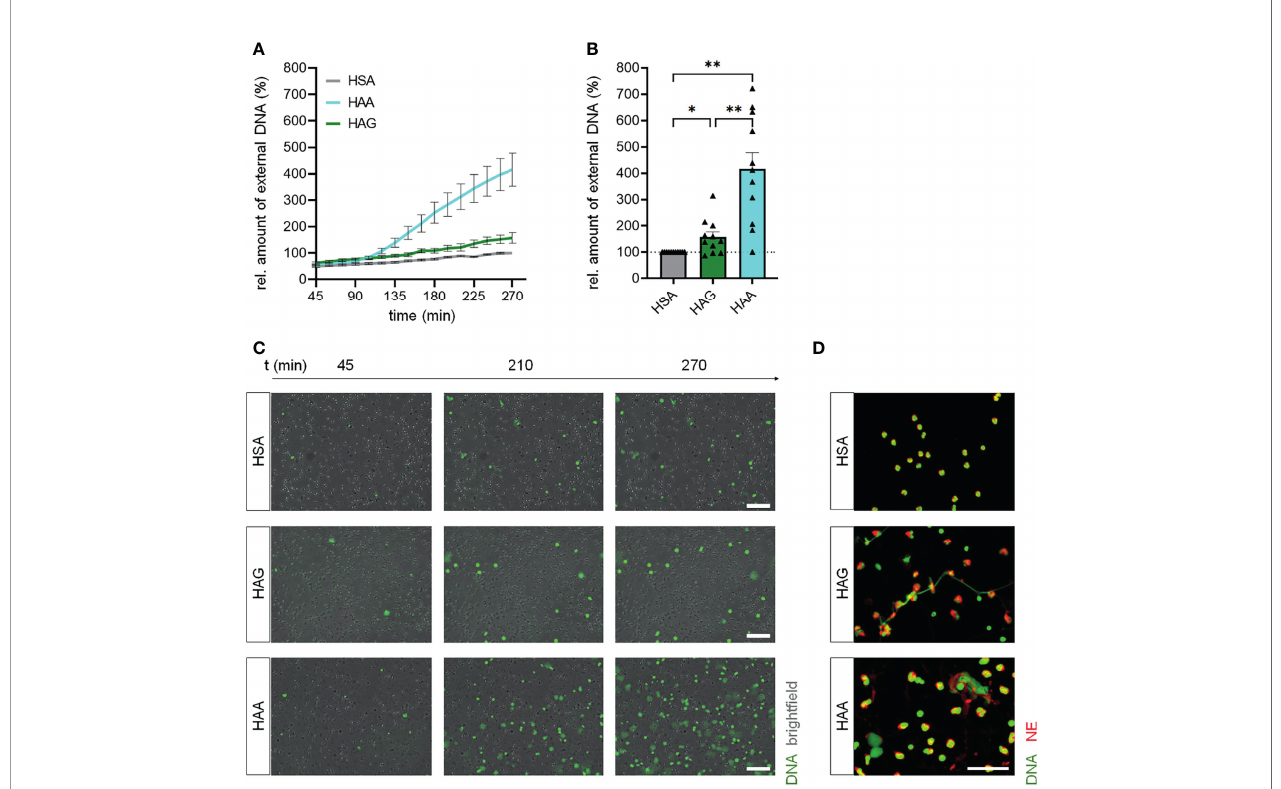
FIGURE 1 | IgA complexes show higher potential to induce NETs than IgG complexes. (A – C) Isolated human blood neutrophils were stimulated with 150 µg/ml heat-aggregated IgG (HAG), heat-aggregated IgA (HAA) or human serum albumin (HSA) as control. NET formation was measured by staining extracellular DNA with Sytox Green. (A) NET formation over time. (B) Relative amount of extracellular DNA 270 min after stimulation normalized on HSA treatment. The dashed line represents the relative amount of NETs of the HSA treated control. N = 11 donors. (C) Representative images at 3 different time points. Scale bar = 100 µm. (D) Representative images of fi xed NETs 270 min after stimulation with HSA, HAG or HAA. Neutrophil elastase (NE) is shown in red, DNA is shown in green. Scale bar = 50 µm. Data are presented as mean ± SEM (A) or scatter plots with bars showing mean and SEM (B) . Signi fi cance was tested with repeated measures one way ANOVA with Geisser Greenhouse correction and S ̌ ı ́ da ́ k ’ s multiple comparisons post hoc test. *p < 0.05 and **p <